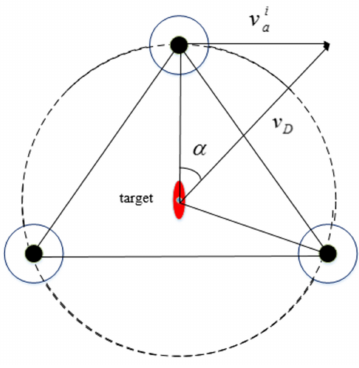
Figure 7. Critical condition analysis diagram of hunting.